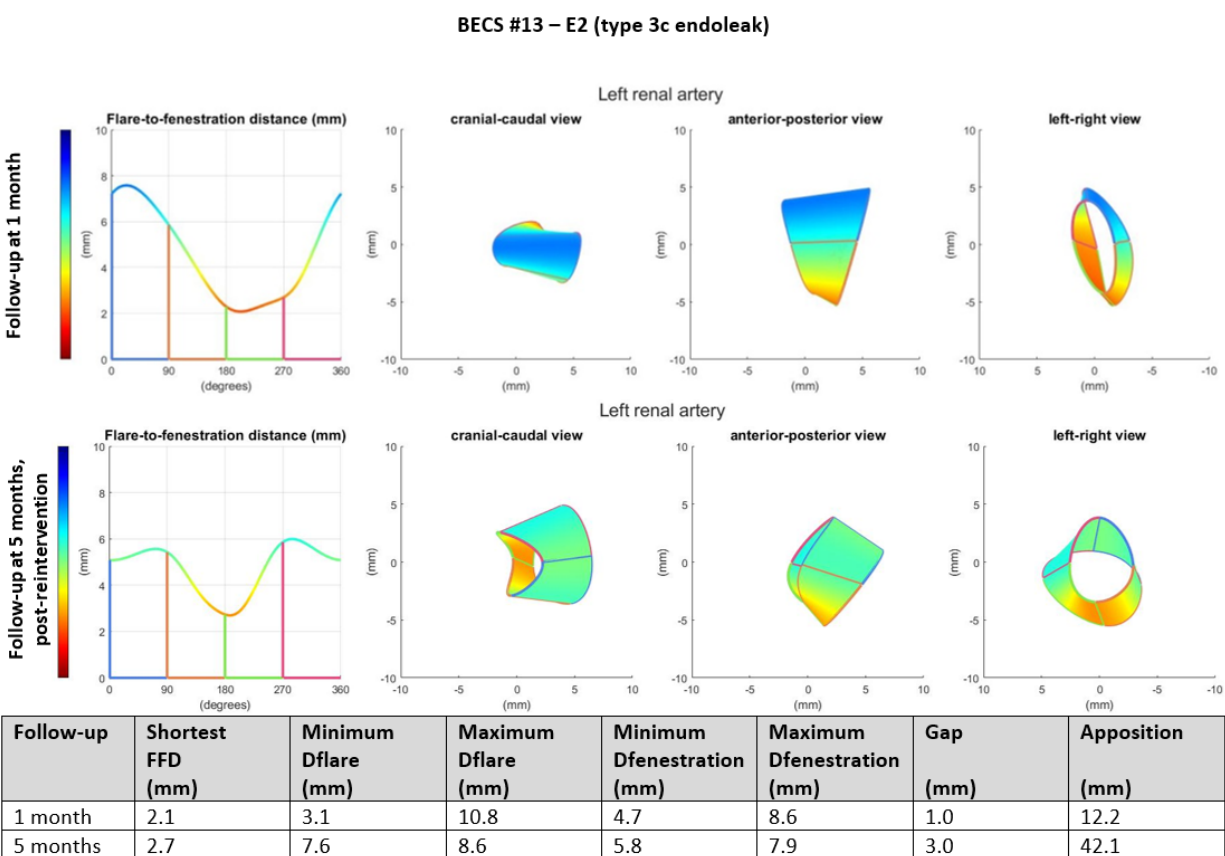
Figure 4. BECS #13 is an example of E2, endoleak due to insufficient flare. Geometric analysis was performed for the 1 ‐ month post ‐ FEVAR CTA scan and post ‐ reintervention CTA scan. Insufficient flaring of the proximal end of the BECS caused a type 3c endoleak on the 1 ‐ month post ‐ FEVAR CTA scan. The geometric analysis shows an oval ‐ shaped flare with a minimum diameter of 3.1 mm. The endoleak was treated successfully by renewed flaring and proximal extension. The geometric analysis of the post ‐ reintervention CTA scan shows a circle ‐ shaped flare with a minimum diameter of 7.6 mm.